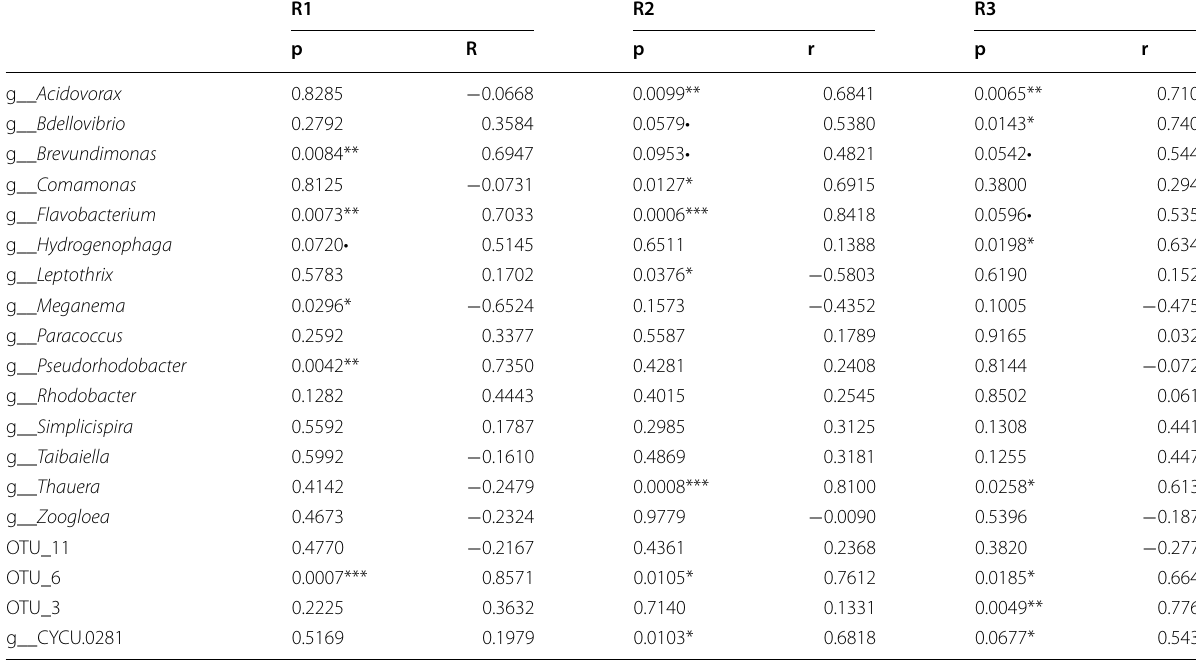
Significant correlations are marked with asterisk(s). Cutoff levels: (•) p < 0.1, (*) p < 0.05, (**) p < 0.01, (***) p < 0.001. For OTU_3, OTU_6 and OTU_11, the closest matches by BLASTn (Altschul et al. 1990) are shown in Additional file 1: Table S2